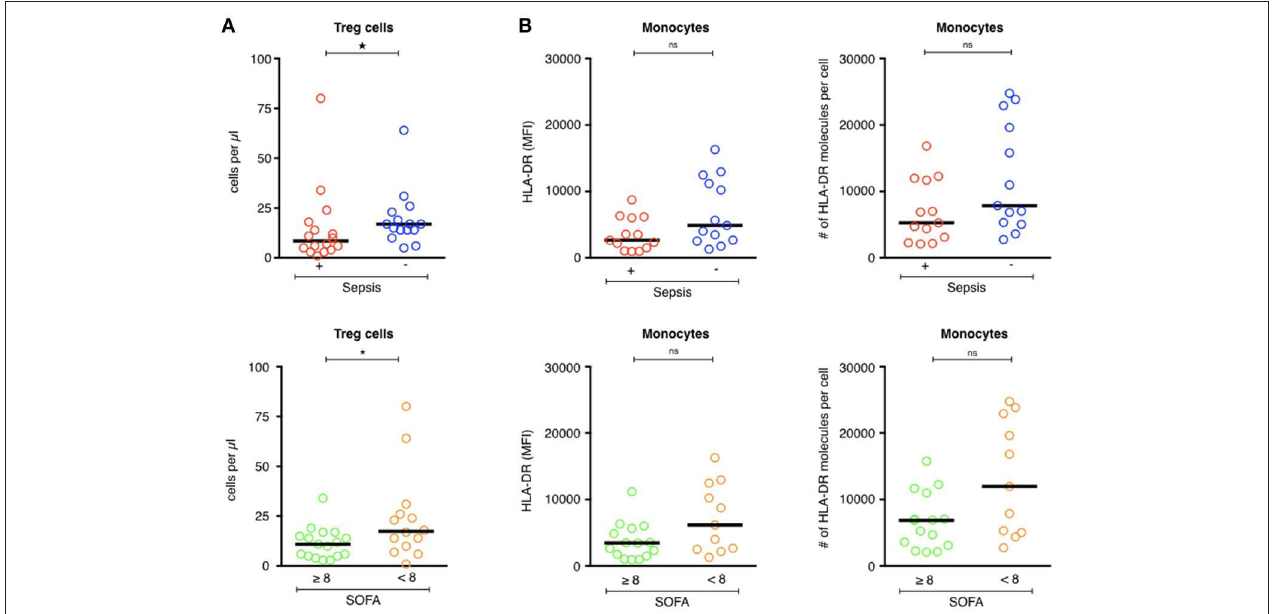
FIGURE 2 | Phenotypic analysis of circulating Tregs and monocytes in ICU patients. ( A , upper) Comparison of Treg cell counts (cells/ µ l) of septic patients (red circles) with those of ICU patients without sepsis (blue circles). ( A , lower) Comparison of Treg cell counts (cells/ µ l) of patients with severe tissue injuries (green circles) with those of patients with less severe lesions (orange circles). ( B , upper) Comparison of the MFI of HLA-DR expression and the number of HLA-DR molecules on monocytes of septic patients (red circles) with those of ICU patients without sepsis (blue circles). ( B , lower) Comparison of the MFI of HLA-DR expression and the number of HLA-DR molecules on monocytes of patients with severe tissue injuries (green circles) with those of patients with less severe lesions (orange circles). The bars show the median. Statistical analyses were performed using the Mann Whitney U -test. Differences were considered significant when P < 0.05: * P < 0.05. ns: not